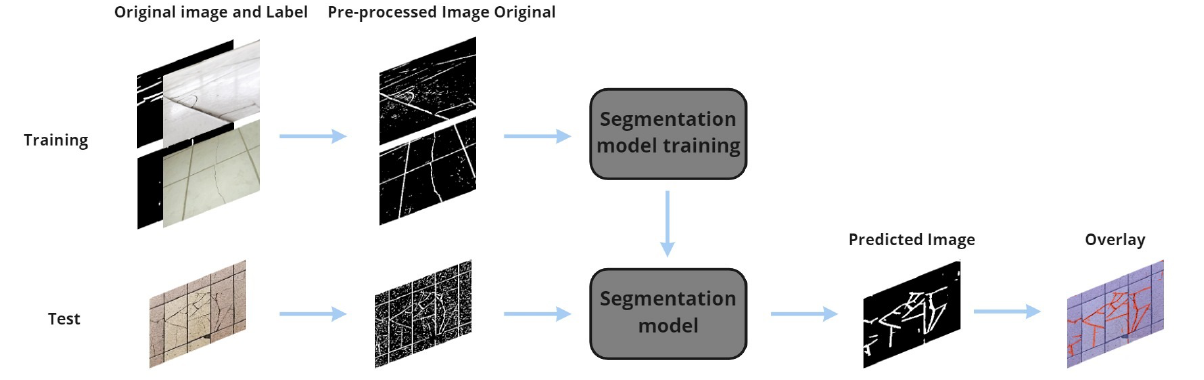
Figure 1. Architecture for crack segmentation in CCS model.